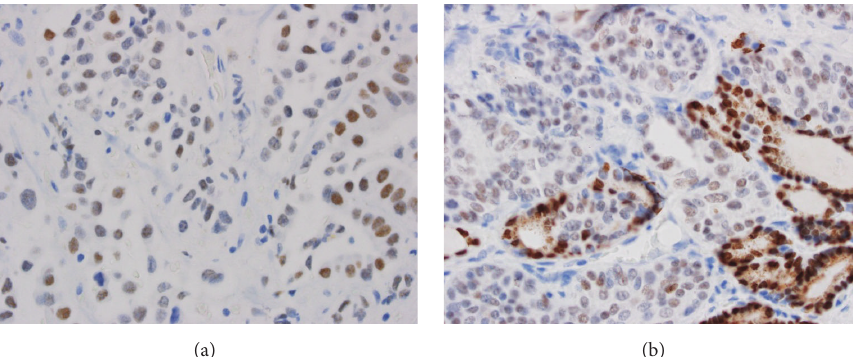
Figure 3: (a) Larynx, TTF-1 stain × 400: weak (light brown) nuclear staining of tumor cells. (b) Thyroid, TTF-1 stain × 400: weak (light brown) nuclear staining of tumor cells with strong (dark brown) nuclear staining of normal thyroid